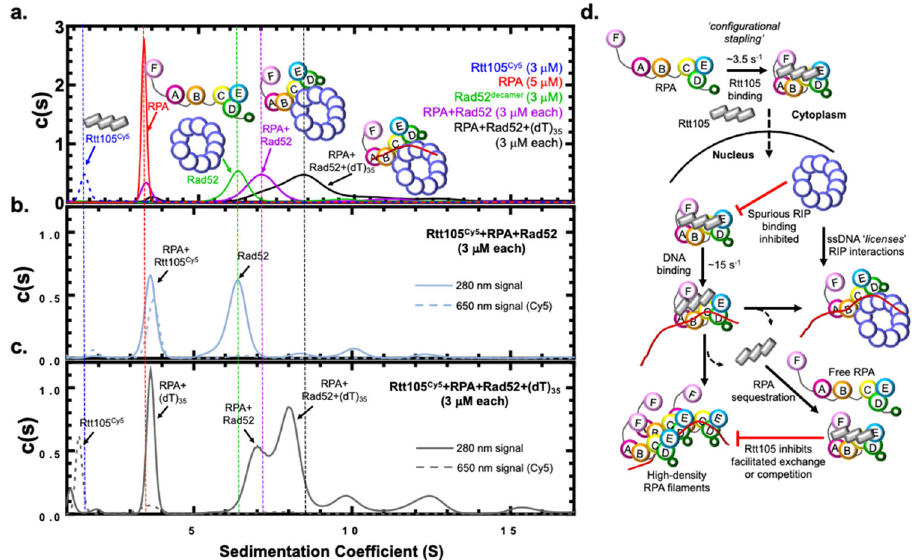
Fig. 7 | Rtt105 inhibits spurious RPA-Rad52 interactions in the absence of ssDNA.a Analyticalultracentrifugation(AUC)analysisofRPA,Rtt105 Cy5 ,Rad52,and the RPA-Rad52 and RPA-Rad52-(dT) 35 complexes show them sedimenting as dis- tinct complexes. The 280nm signals were monitored for all the proteins and complexes except Rtt105 Cy5 which was monitored at 650nm (dashed line). The horizontaldottedlinesserveasavisualguideforthesedimentationpositionsofthe denotedproteinsacrossalltheAUCexperimentpanels. b Rtt105 Cy5 ,RPA,andRad52 were mixed in equimolar concentrations and analyzed. In the presence of Rtt105, Rad52 does not interact with RPA and sediments independently while RPA and Rtt105 remain as a complex. c When an equimolar amount of ssDNA [(dT) 35 ] is present, Rtt105 is displaced and sediments similar to free Rtt105. RPA and Rad52 partition into multiple RPA+DNA, RPA+Rad52, and RPA+Rad52+DNA complexes.